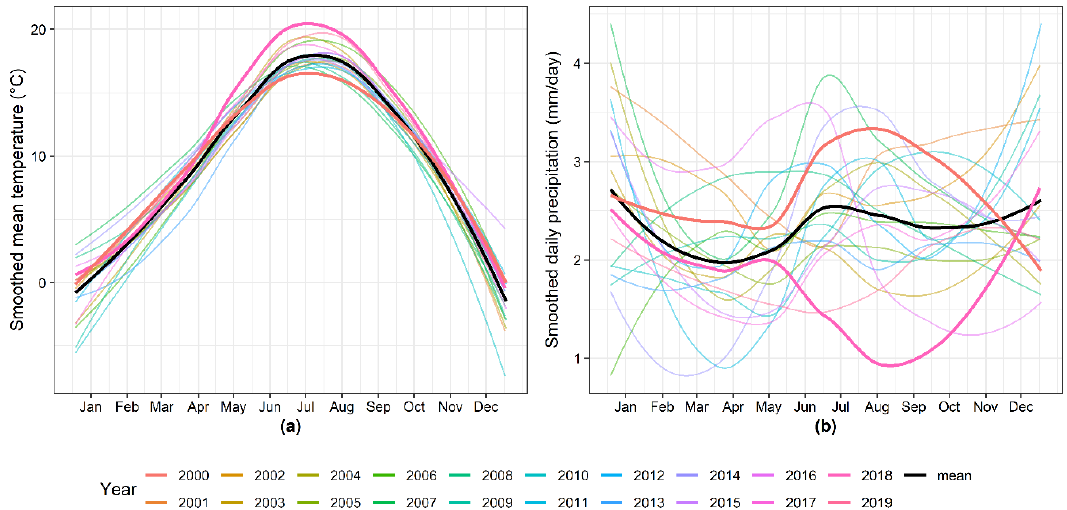
Figure 4. LOESS-smoothed daily mean temperature (a) and daily precipitation (b) in Liège from 2000 to 2019. The black line is the average of the whole period. Two thick lines represent years with an unusually cool and wet summer (2000), and an abnormally hot and dry summer (2018).